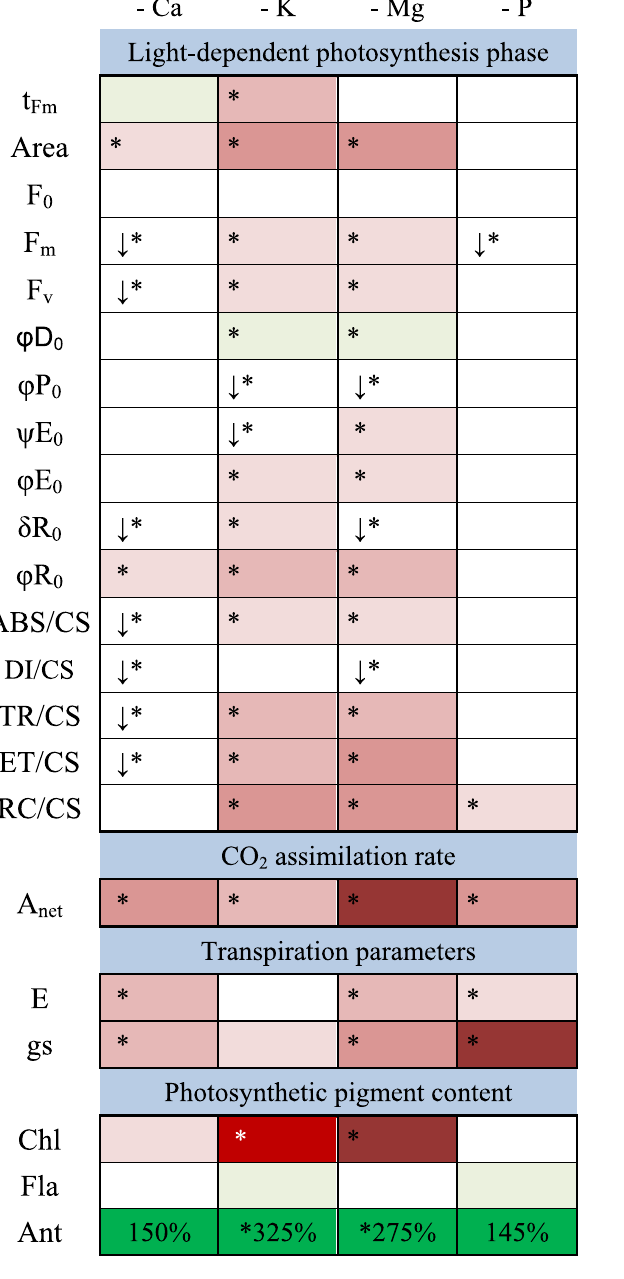
Table 2. Changes in parameters describing photosynthetic apparatus performance of maize under deprivation of Ca, K, Mg or P. Asterisks show the statistical significance for each parameter compared with the control (ANOVA, LSD test, P < 0.05). Arrows describe the direction of statistically significant change when it is in the range ± 5% of the